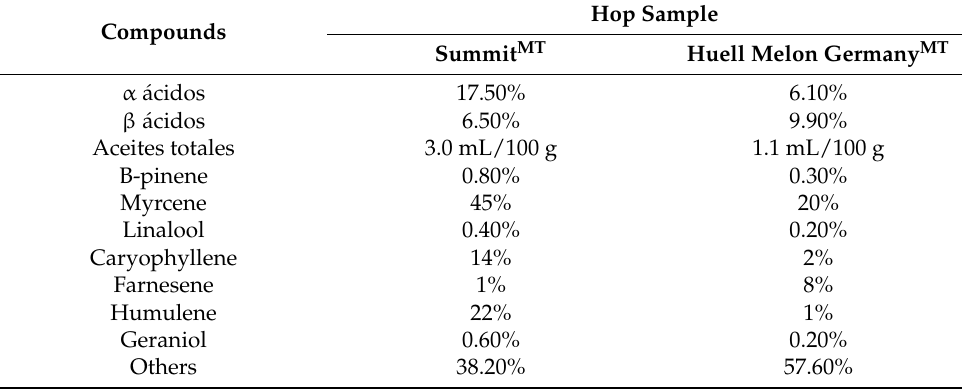
Table 1. Compounds present in hop